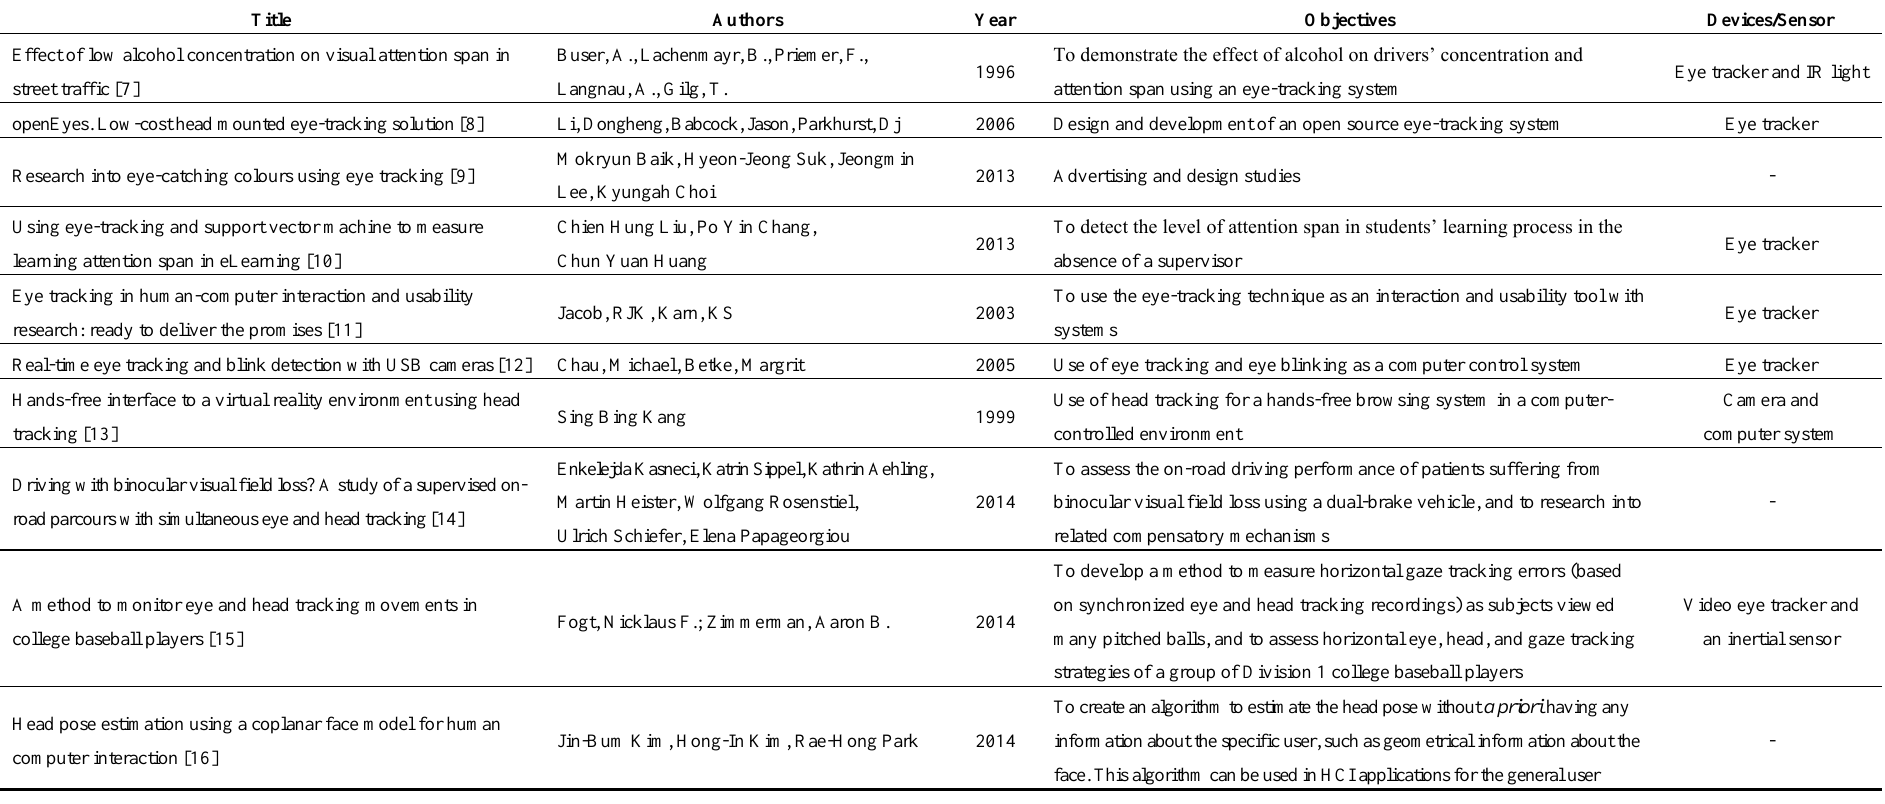
Table 2. Tracking-related projects.